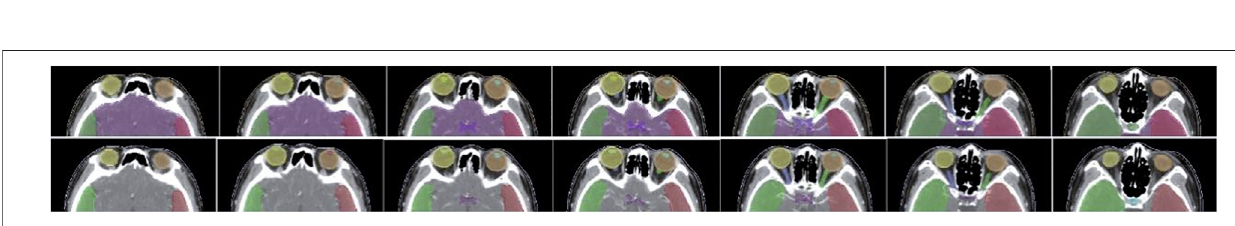
Frontiers in Physics |